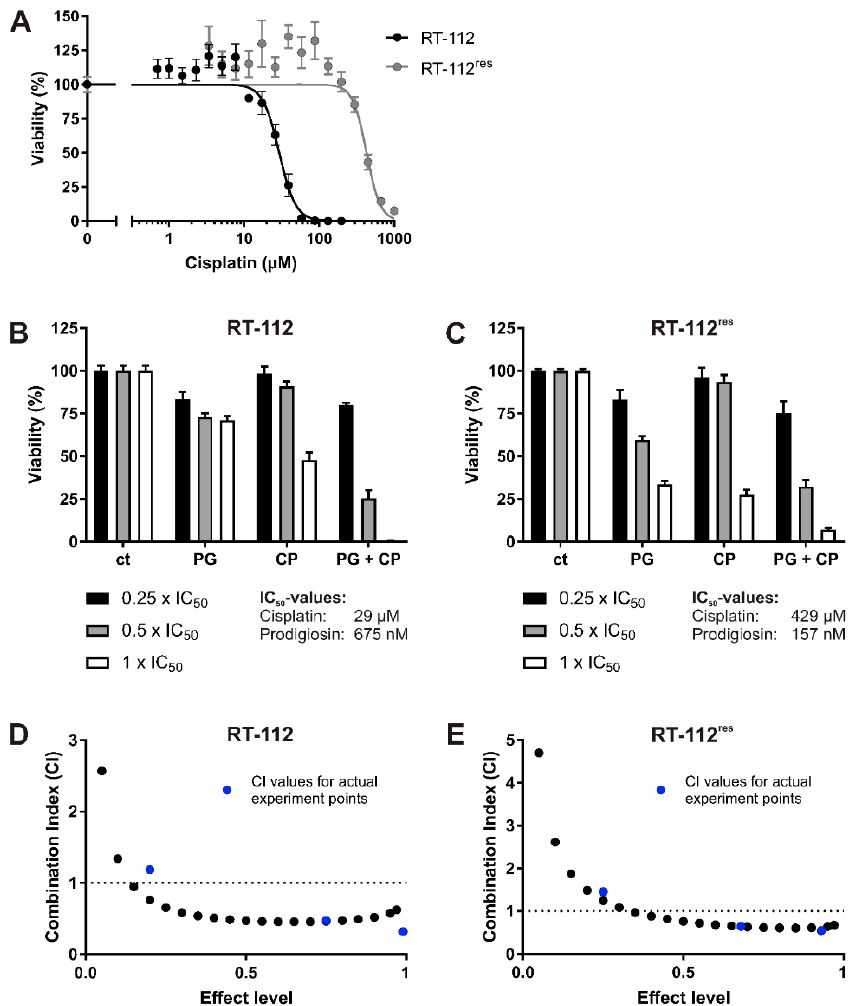
Figure 5. Prodigiosin increases cisplatin-mediated cytotoxicity in RT - 112 and RT - 112 res cells after 24 h. RT - 112 and RT - 112 res cells were treated with different concentrations of ( A ) cisplatin (CP) alone or ( B,C ) prodigiosin (PG) or CP alone or in combination for 24 h. For combinatory analysis, 0.25x, 0.5x or 1x of the IC 50 values of the single substances in RT - 112 ( B ) and RT - 112 res ( C ) were used. After treatment, cell viability was measured using an MTT assay. Results are shown as the mean ± SEM of three independent experiments performed in triplicates for each treatment. The combination index (CI) for different fractions affected of RT - 112 ( D ) and RT - 112 res ( E ) was calculated using the software CompuSyn (black dots). CompuSyn uses algorithms to extrapolate CI values for any effect level from the CI values of actual experiment points (blue dots). Synergism (CI < 1), additivism (CI = 1) and antagonism (CI > 1) can thereby be determined.